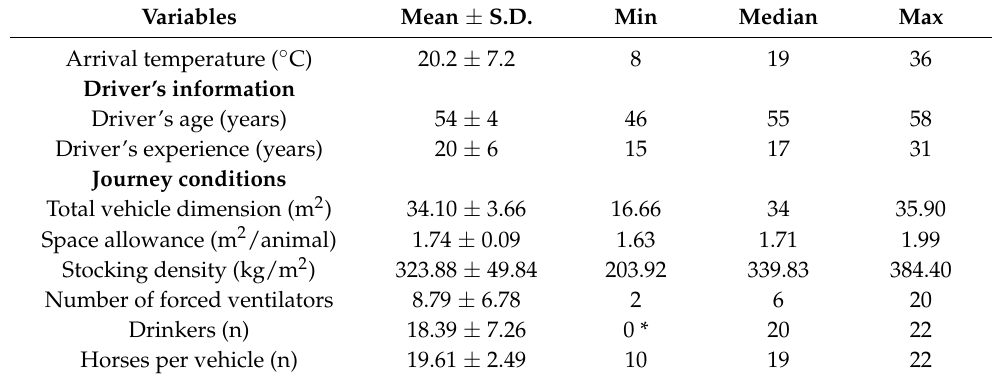
Horses per vehicle